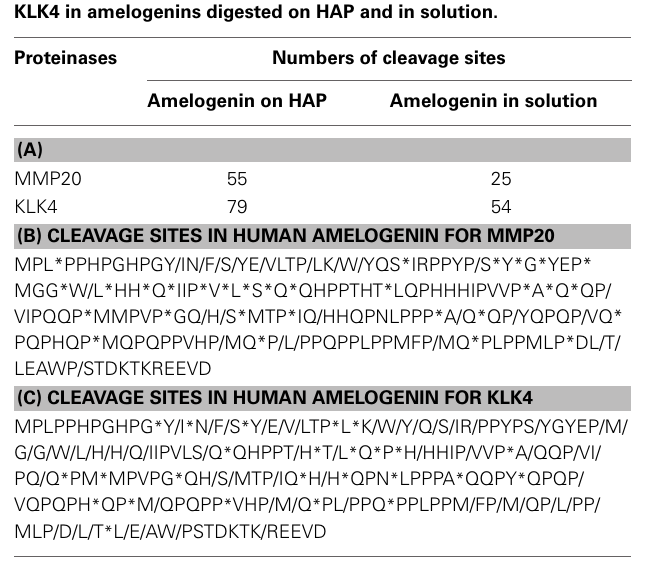
together. Therefore, the layers of amelogenin adsorbed on crystal surface need to be preferentially removed to open up the space for the growth of a new layer of crystals, while still having relatively intact surrounding protein matrix to support the thin and fragile nascent